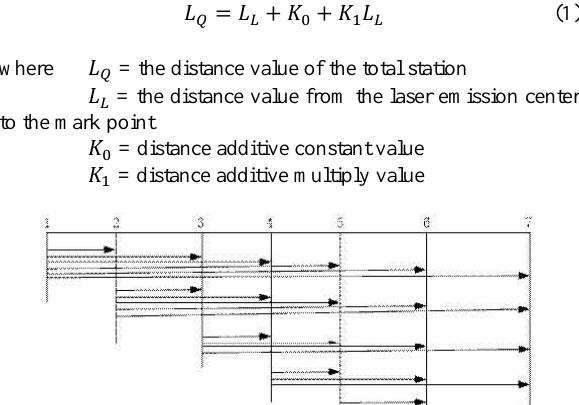
Figure 8. Point cloud result after